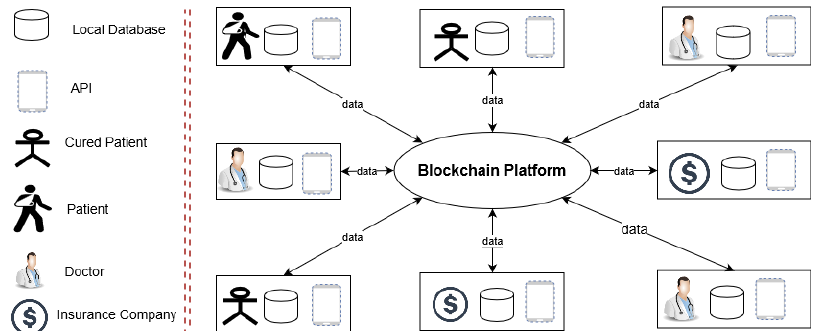
Figure 5. Stakeholders (participating entities) collaborating for medical decision gathering in PoF.